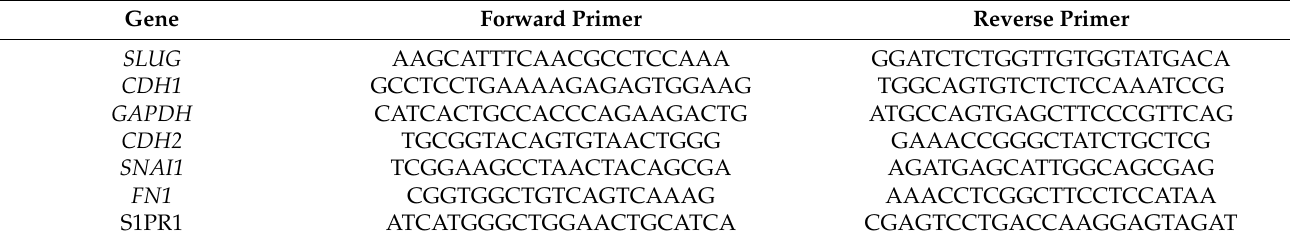
Table 1. Primer sequences used in the qPCR